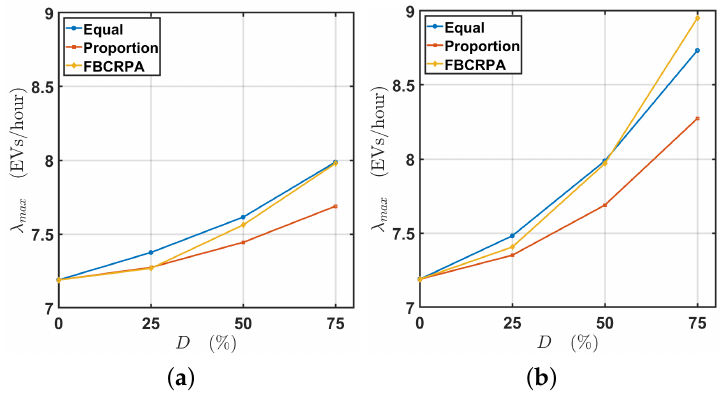
Figure 5. λ max of three schemes. ( a ) M = 0.5. ( b ) M =